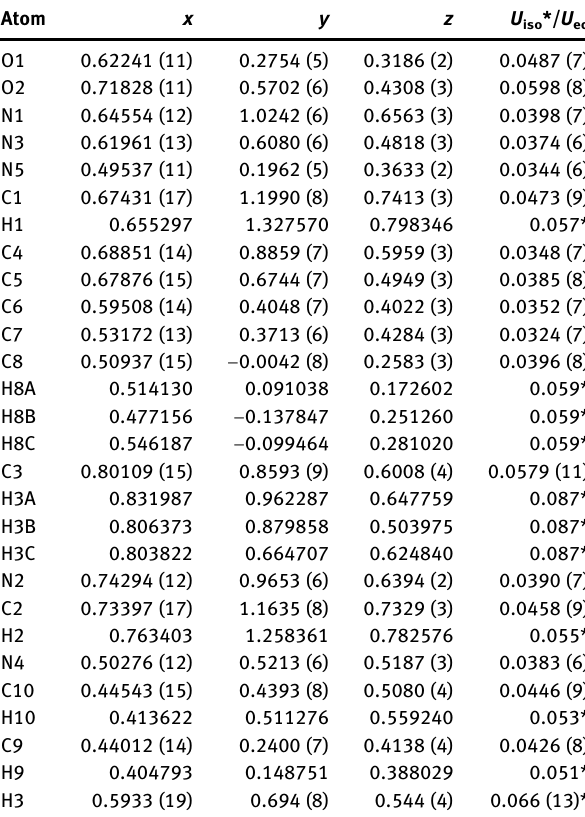
Table  : Fractional atomic coordinates and isotropic or equivalent isotropic displacement parameters (Å 